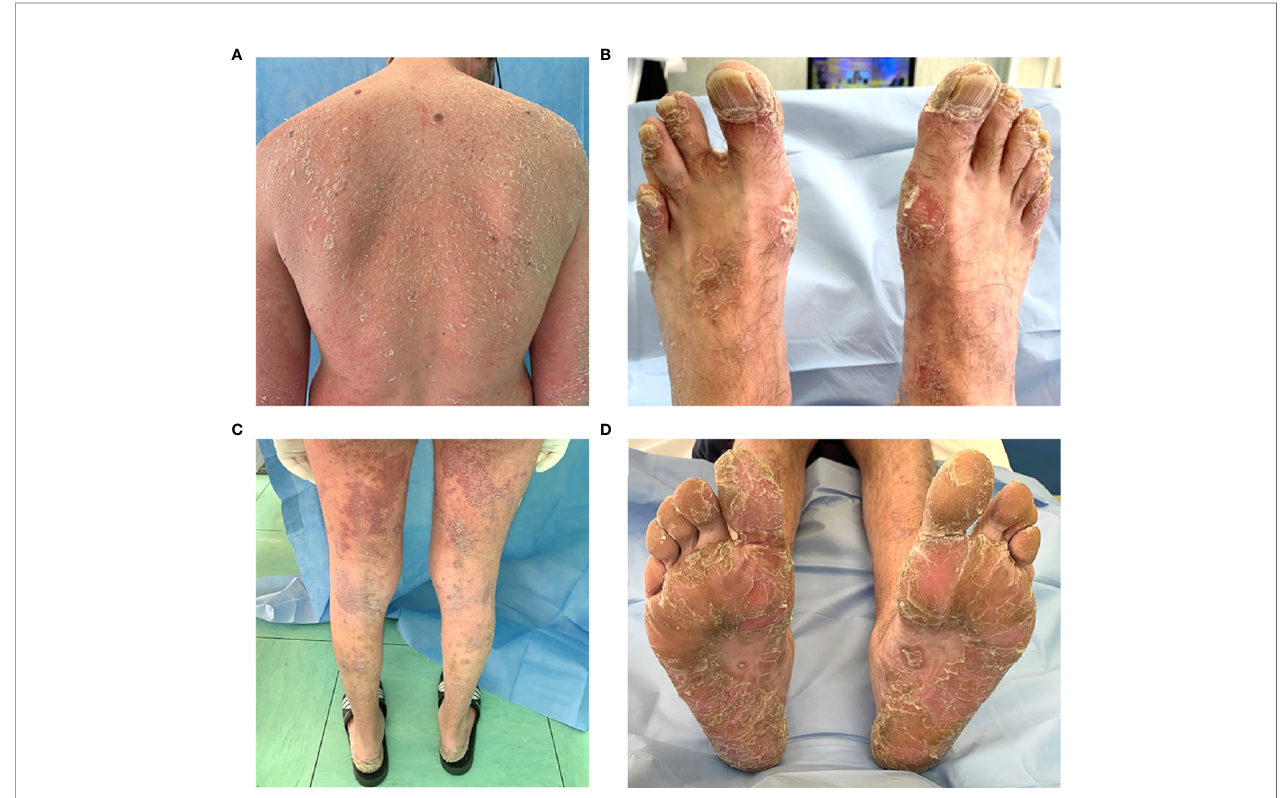
FIGURE 4 | Severe psoriasis in a patient with common variable immunode fi ciency. (A – D) Erythrodermic psoriasis diffuse to the entire body with a red and peeling rash. (B) Nail psoriasis is evident at toenails, causing pitting, discoloration and onycholysis. (C) Symmetrical erythematous plaques with sharp edges and covered with pearlescent scales, located on the posterior surface of the legs. (D) Palmoplantar psoriasis involving symmetrically palms of the hands and soles of the feet; squamae are the predominant